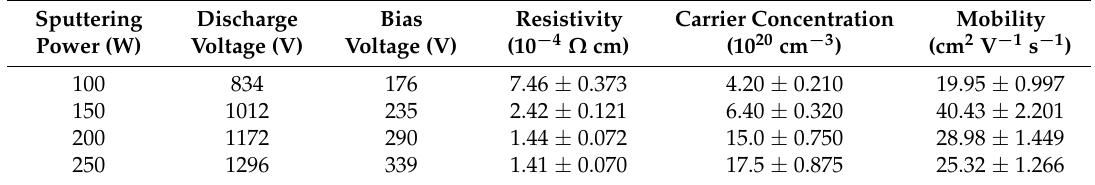
Figure 6. Electrical properties of multiple structure nanopillar crystalline films, including resistivity, carrier concentration, and mobility. Table 1. Discharge voltage and Bias voltage under different sputtering powers; Resistivity, carrier concentration and mobility of the multiple structure nanopillar films.